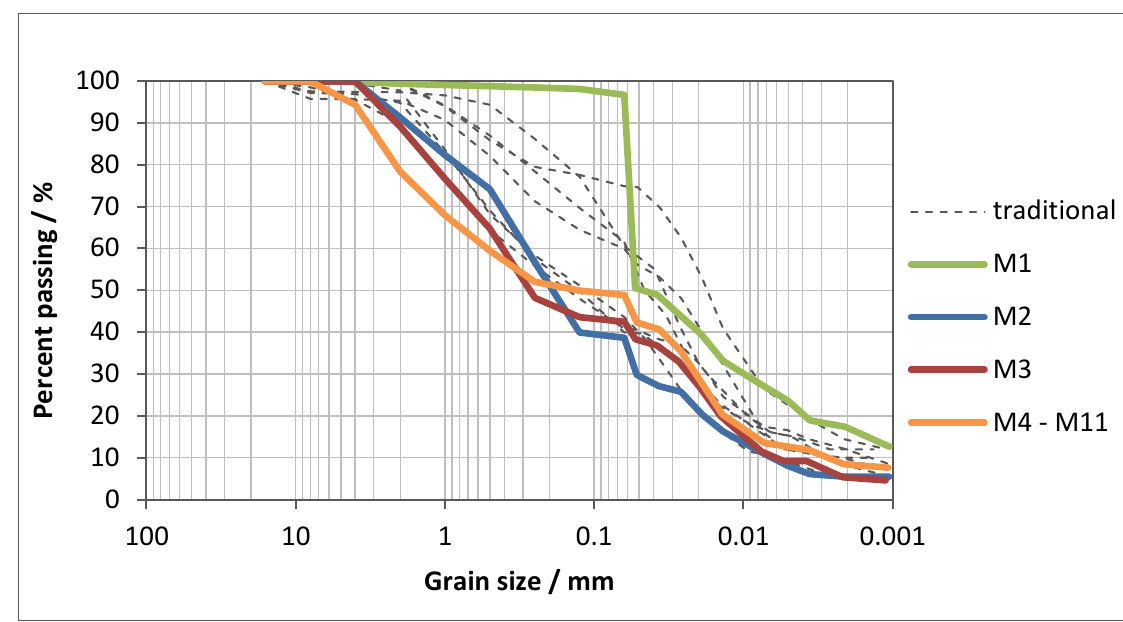
Figure 4. Grading curve of mixtures M1–M11. Table 2. Grading parameters of traditional and reproduced mixtures.